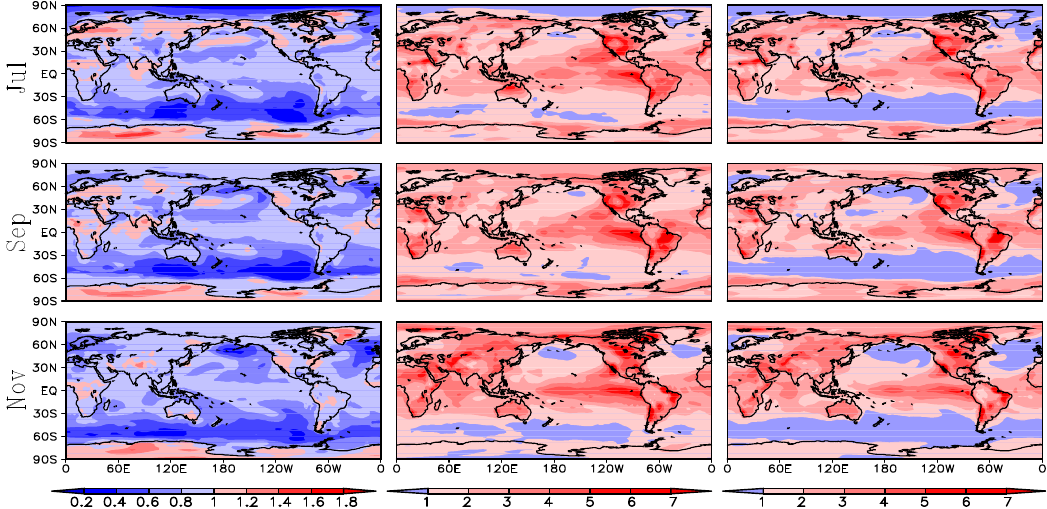
AB ( left ), CA ( middle ), and CB ( right ), for DT PD PT